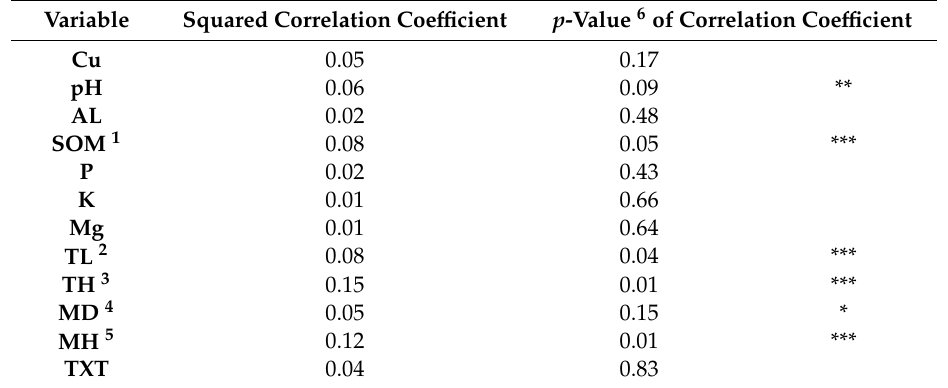
Table 3. Correlation analysis of environmental drivers and soil characteristics with NMDS ordination pattern. Variable Squared Correlation Coefficient p -Value 6 of